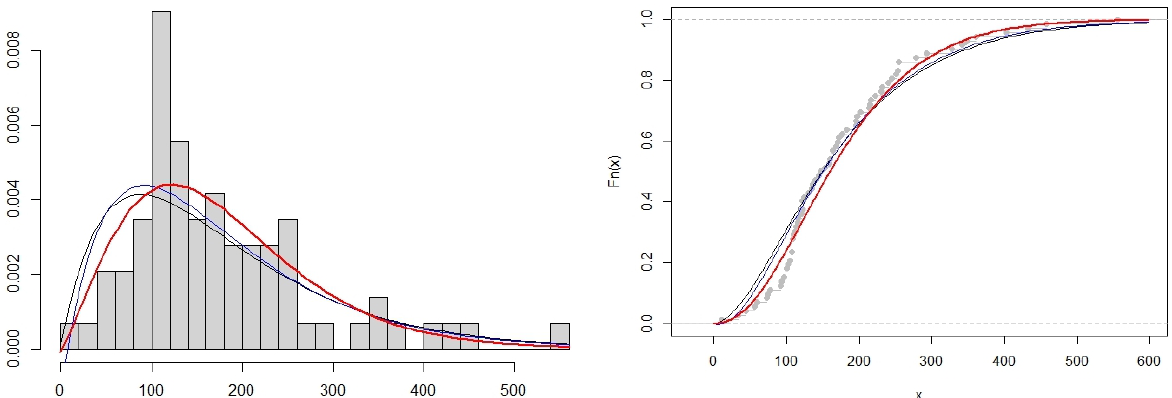
Figure 4. Fitted Lindley (black), 3PL (blue), and ncL (red) models with corresponding estimated distribution functions for the guinea pigs